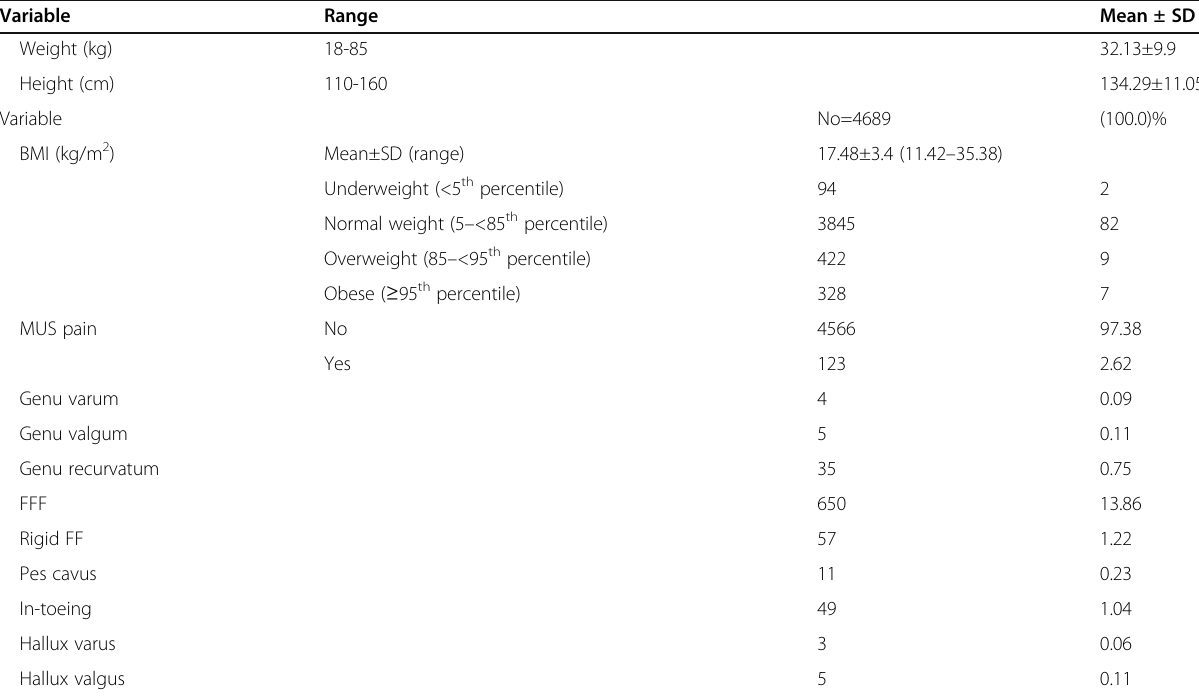
Table 1 Clinical data of the studied